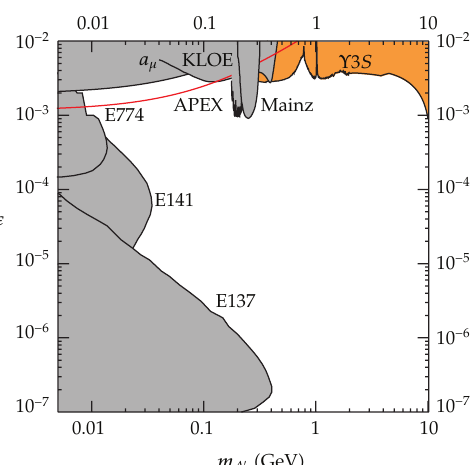
Figure 4: Constraints on the mixing strength, (cid:8) , as a function of the hidden photon mass derived from searches in Υ(cid:2) 2 S, 3 S (cid:3) decays at BABAR (cid:2) orange shading (cid:3) and from other experiments (cid:2) gray shading (cid:3) . The red line shows the value of the coupling required to explain the discrepancy between the calculated and measured anomalous magnetic moment of the muon (cid:5) 35 (cid:6)